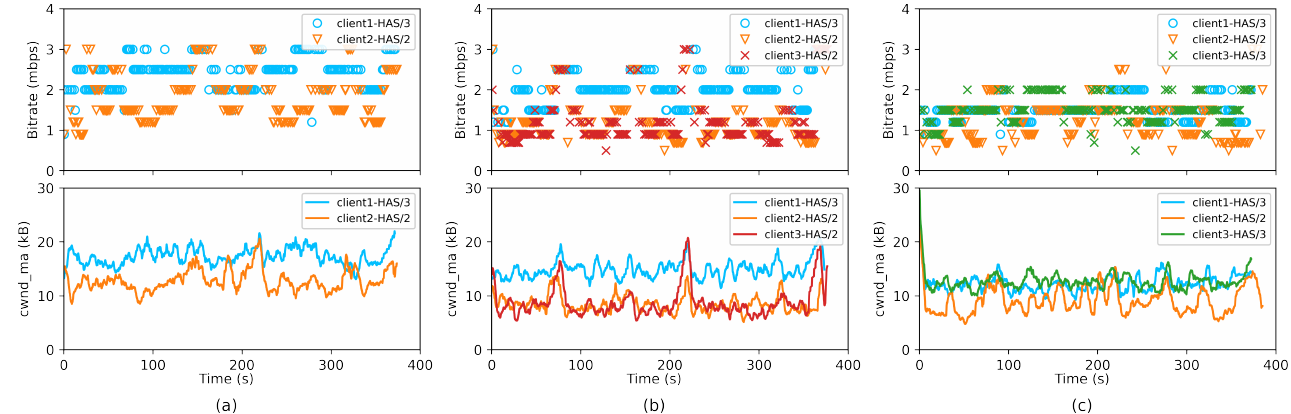
Figure 4. The representative time-varying bitrates and cwnd _ ma of the clients running the general ABR with B = 5 (mbps), under the scenario ( a ) S 11 , ( b ) S 12 and ( c ) S 21 .